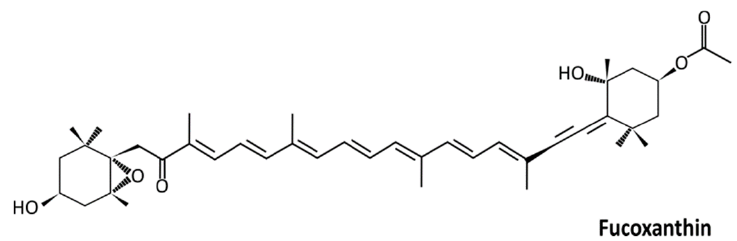
Figure 2. The chemical structure of fucoxanthin [89].